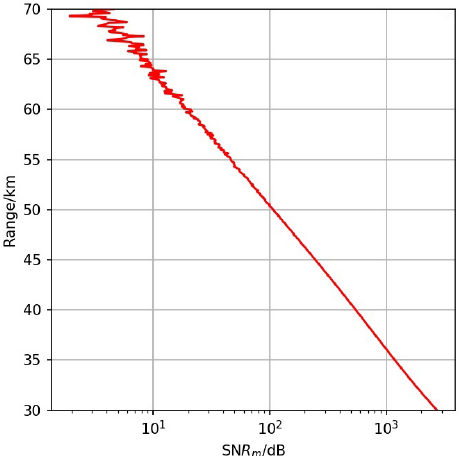
Figure 5. The SNR m changes with height.